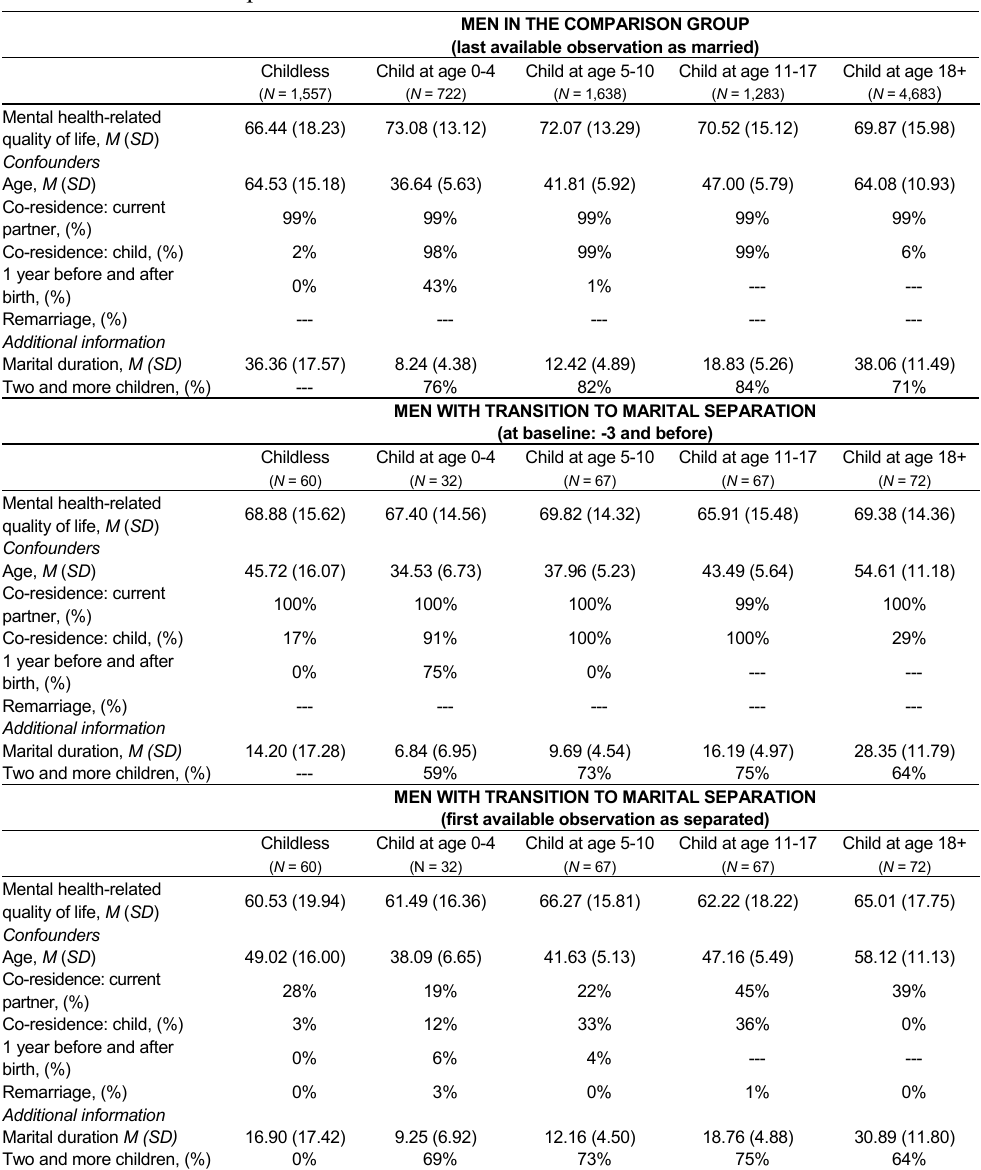
Table 2 : Sample composition by age of the youngest biological child before and after marital separation for men MEN IN THE COMPARISON GROUP (last available observation as married) Child at age 0-4 Child at age 5-10 Child at age 11-17 Child at age 18+ Childless ( N = 4,683 ( N = 1,557) ( N = 722) ( N = 1,638) ( N = 1,283)